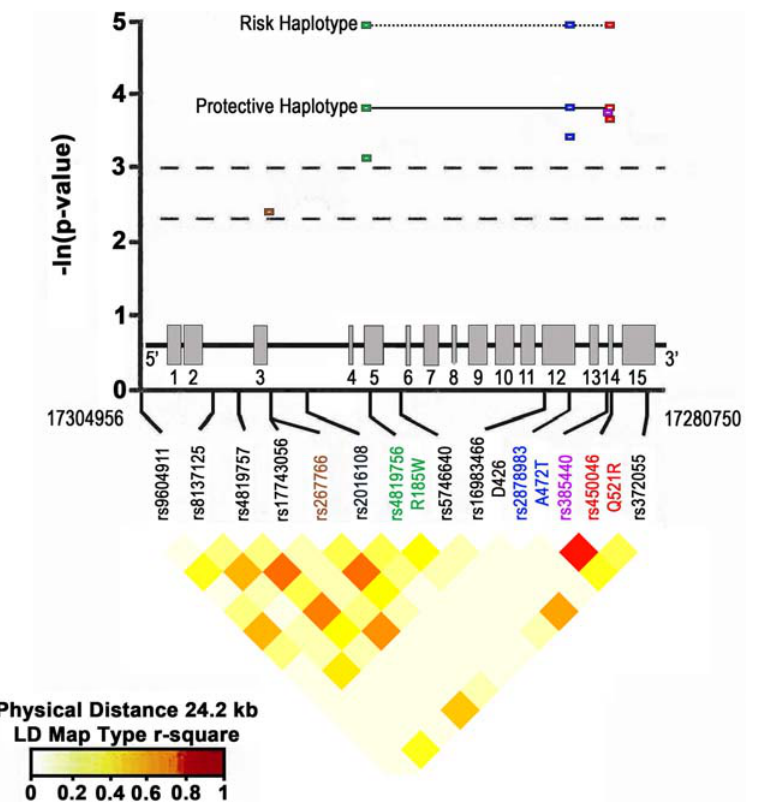
Figure 1. Genetic Association results. Above) 2 ln(p) clinical results for significant SNPs and functional haplotypes. Non-synonymous functional coding SNPs are labeled with coding changes. Exon structure is for most common transcript. Below) r 2 heat map for CBDB normal controls of European descent as visualized in snp.plotter demonstrates the relatively low level of linkage disequilibrium across this region.